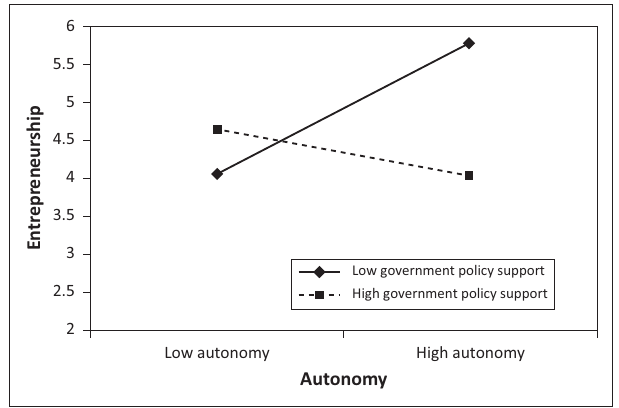
FIGURE 2: Moderating effect of government policy support on the autonomy- entrepreneurship